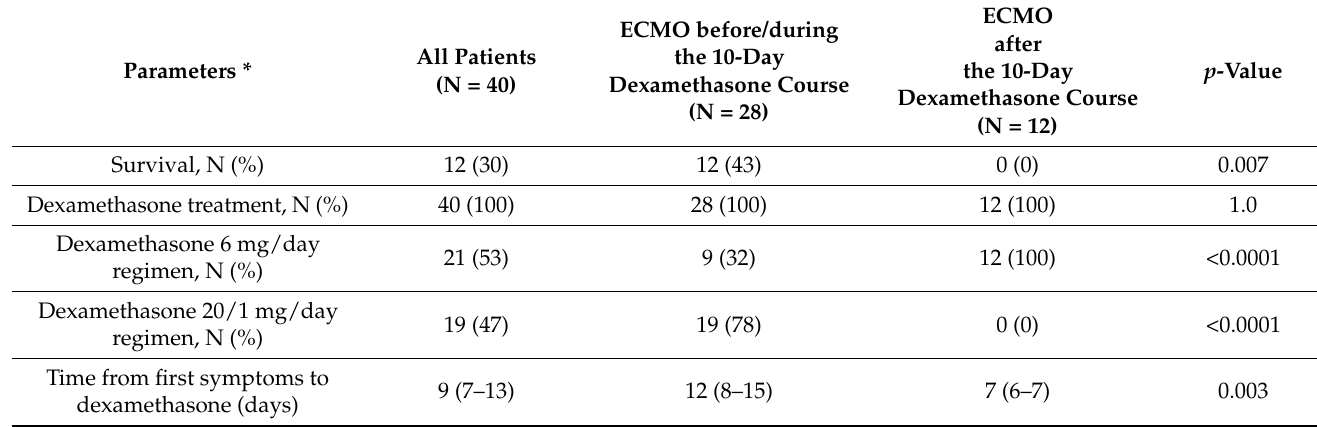
Table 3. Survival and immunomodulatory drugs, mechanical ventilation, and